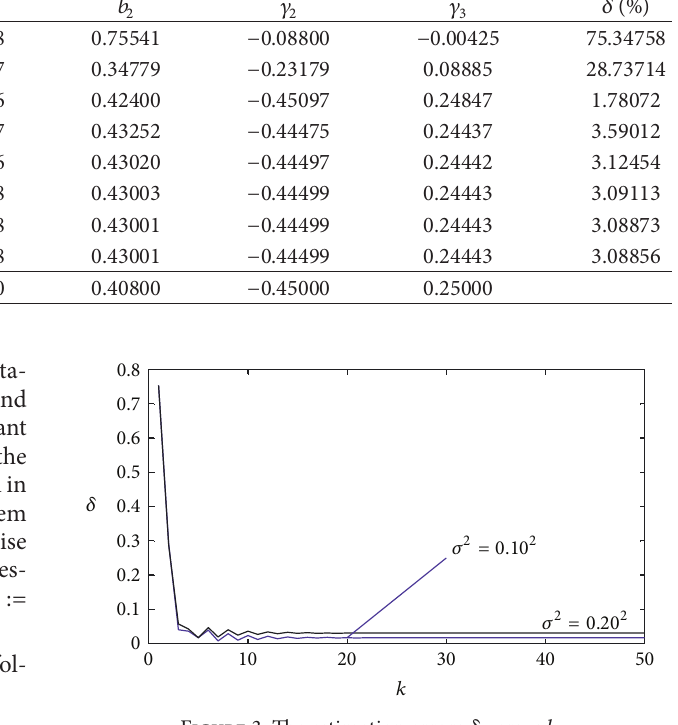
Figure 3: The estimation errors 𝛿 versus 𝑘